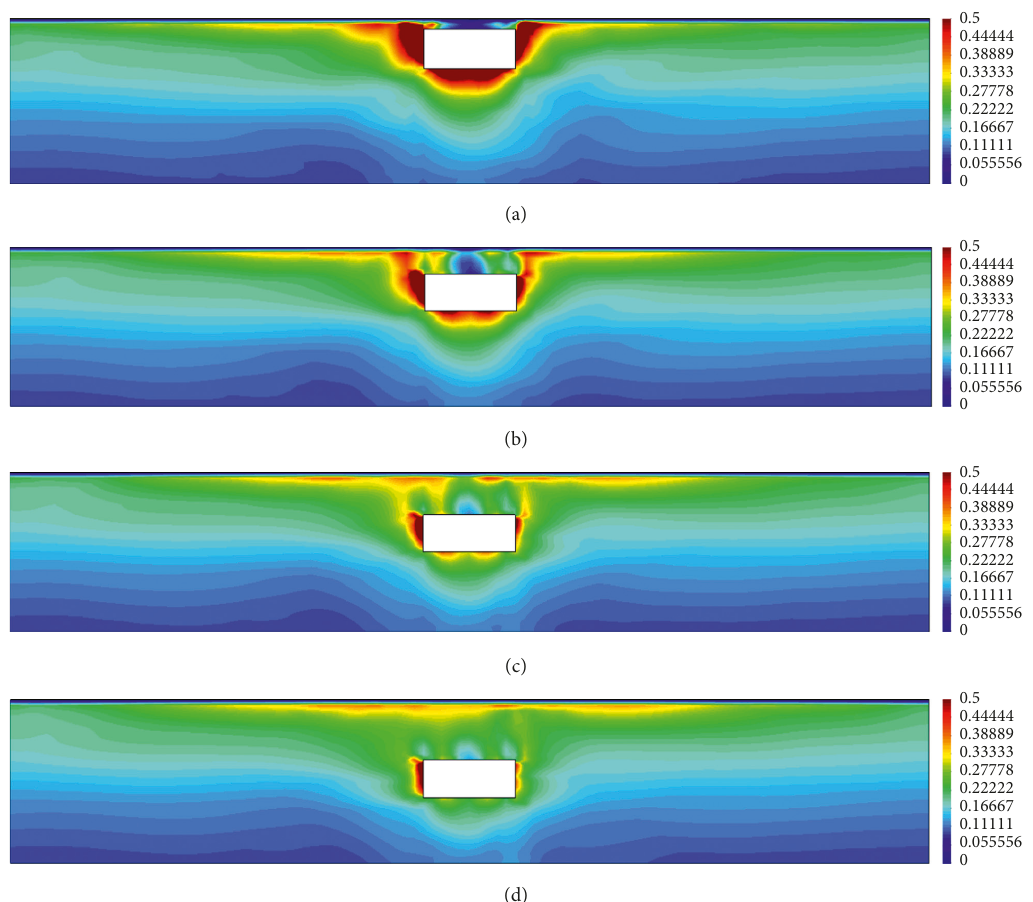
Figure 10: Contours of peak response of the dynamic pore pressure ratio of soft soil ground with different burial depths: (a) 2m; (b) 5m; (c) 8m; (d) 11m.